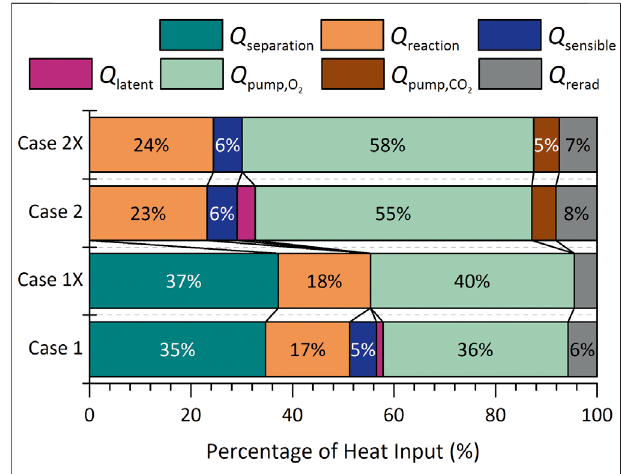
FIGURE5| Distributionofthecomponentsof Q in forthedual-membrane reactor.Case1: p I (cid:2) p II (cid:2) 1 bar.Case2: p I (cid:2) 10 bar, p II (cid:2) 0.1 bar.Thesuf fi x “ X ” denotes the cross-stream arrangement of heat exchangers, whereas in the standard arrangement the inlet and outlet of the same stream exchange (cid:2) 10 heat. T (cid:2) 1,800 K and p O 2